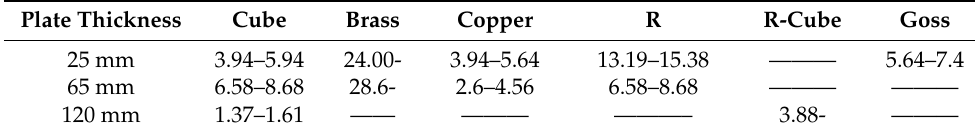
Figure 3. ODF maps of hot rolled plates: ( a ) 25 mm, ( b ) 65 mm, ( c ) 120 mm. Table 1. The texture types and orientation density of the